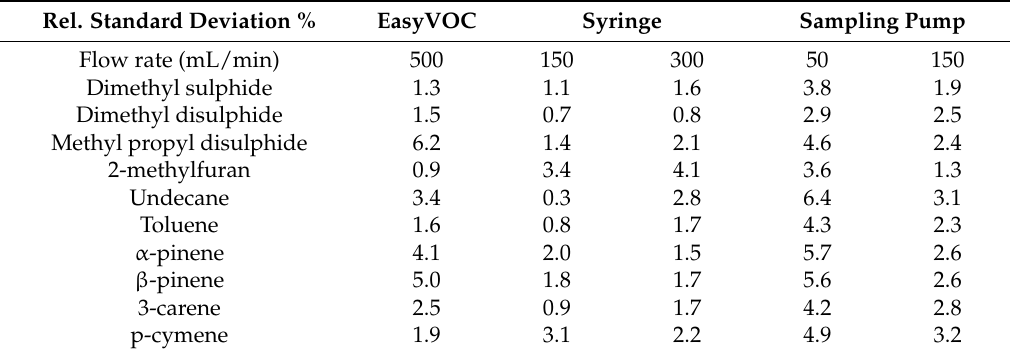
Table 1. Relative standard deviation ( n = 10) of the 3 methods and VOCs.